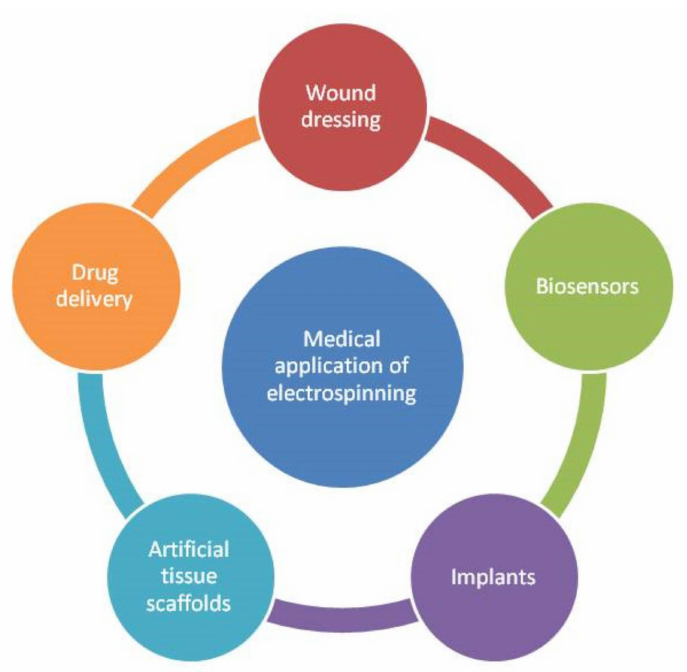
Figure 3. Medical applications of